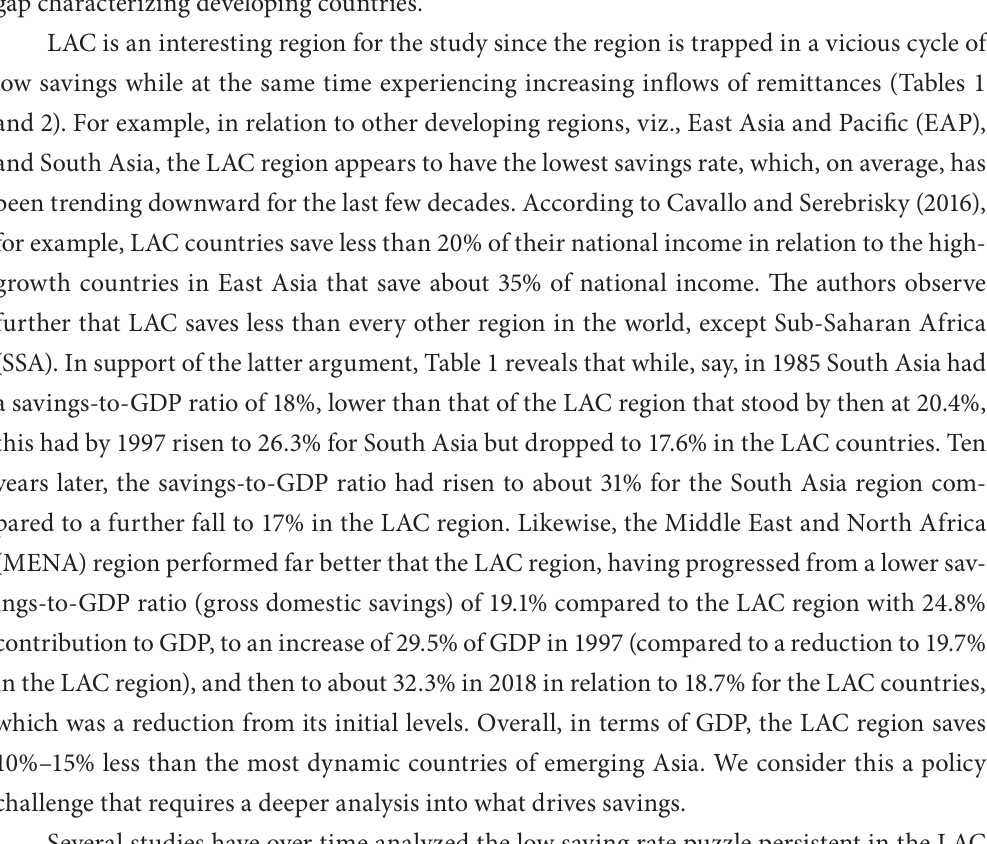
Savings and remittances (% of GDP) for selected developing regions East Asia & Pacific South Asia Latin America &